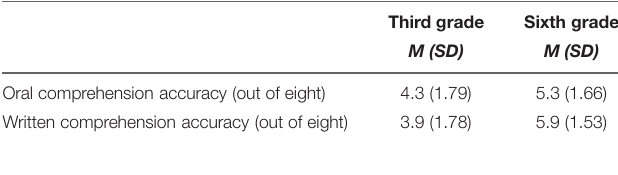
TABLE 1 | Results in comprehension questions of the initial participants.